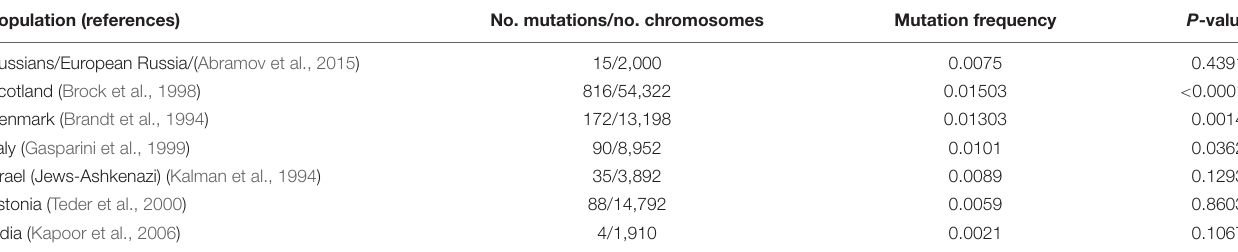
FIGURE 2 | Location of studied populations. Russians – Pskov, Tver, Kirov, Rostov-on-Don. Volga-Ural region: Yoshkar-Ola – Mari; Cheboksary – Chuvashes; Kazan – Bashkirs; Izhevsk – Udmurts; Ufa – Bashkirs. North Caucasus region: Inzhich-Chukum – Abaza; Erken-Shakar – Nogais; Khabez – Circassians; Karachaevsk – Karachay; Vladikavkaz – Ossetians; Grozny – Chechens. TABLE 2 | F508del mutation frequencies in some populations of the world (comparison on Russians of European part of Russia). Population (references) No. mutations/no. chromosomes Mutation frequency P